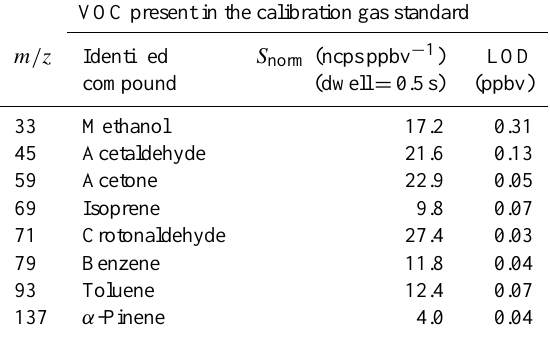
Table 1. Normalized sensitivities derived from the gas calibration. Limit of detections calculated as two times the standard deviation of the noise (ncps) divided by the normalized